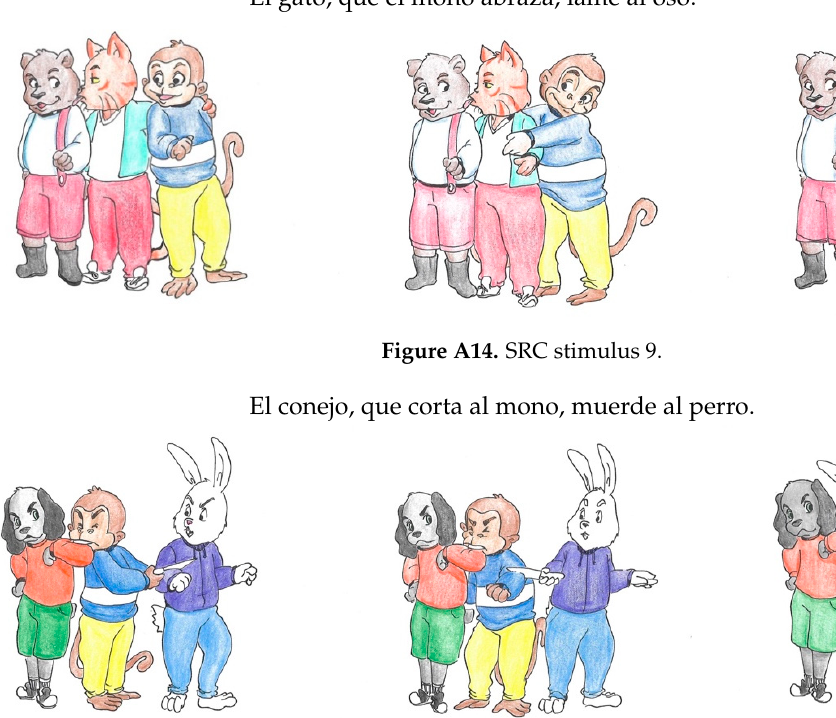
Figure A15. SRC stimulus 10.